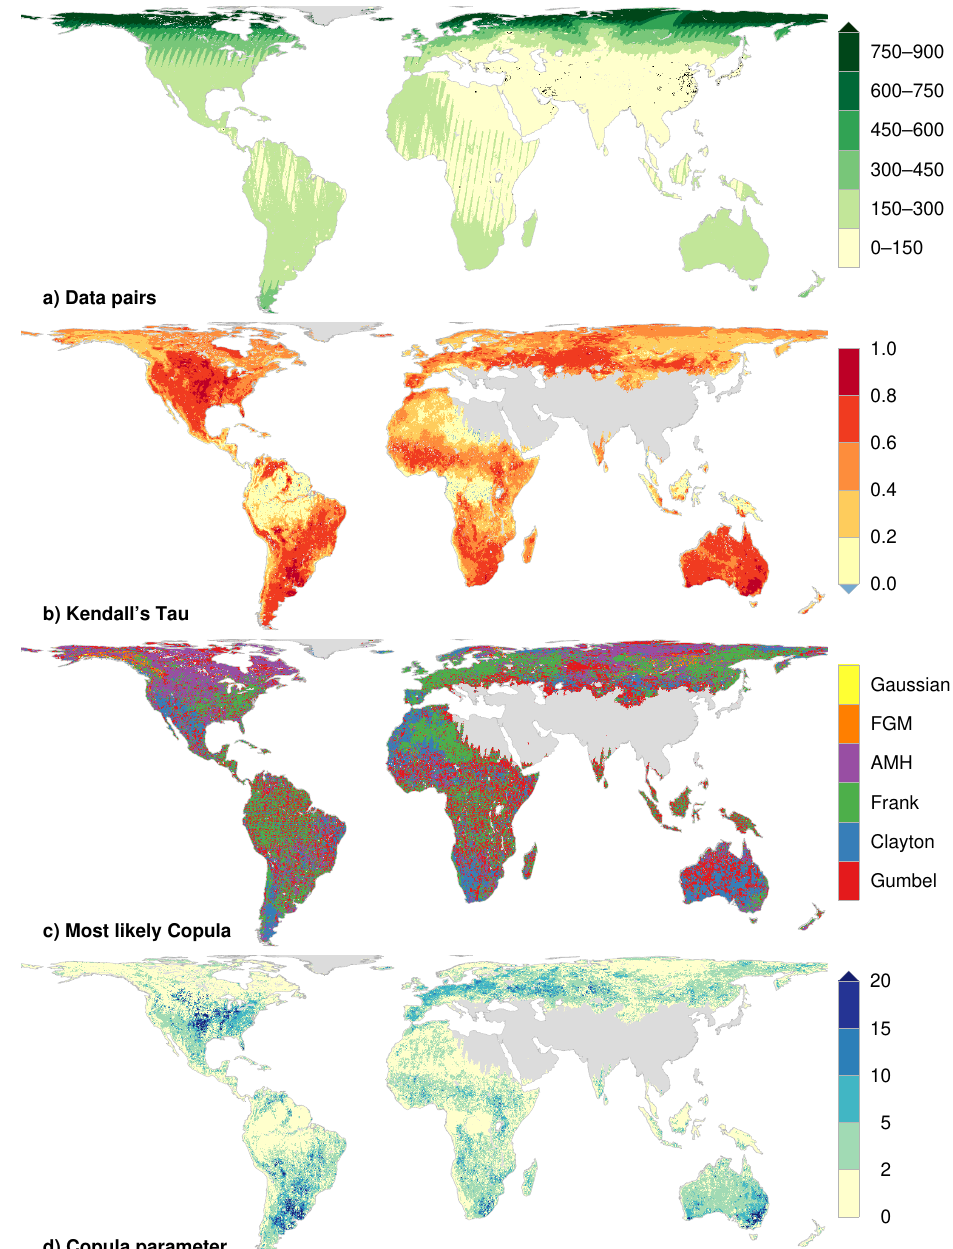
Figure 2. ( a ) Number of simultaneous (within six hours) retrievals from SMOS and SMAP Enhanced (SMAP_E) during the period April 2015–March 2018 in every 9km grid cell. ( b ) Rank correlation coefficient Kendall’s τ between daily SMOS and SMAP_E brightness temperatures. ( c ) Most likely copula model from the Bayesian copula selection. ( d ) Copula parameter θ for the most likely copula model. FGM, Farlie–Gumbel–Morgenstern; AMH,